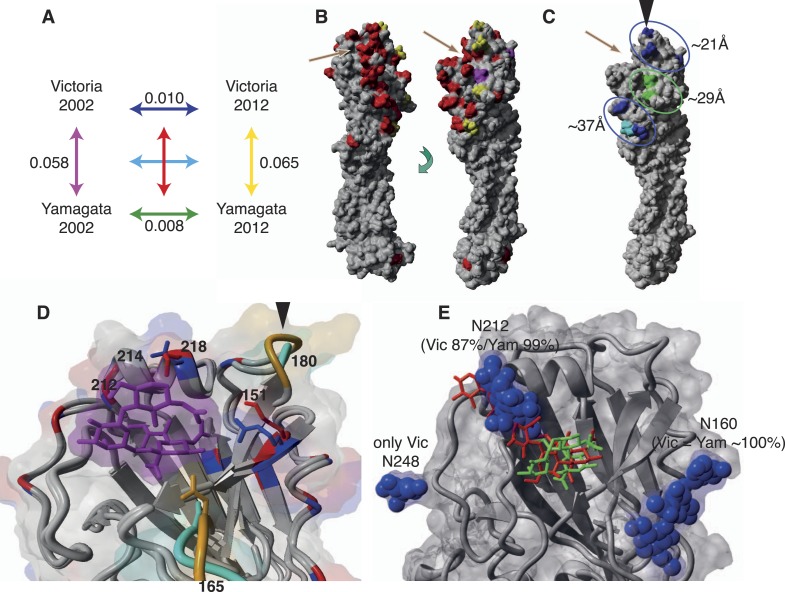
Structural view of the HA showing mutational accumulation and lineage
differences.Amino acid changes observed within and between influenza B virus lineages
(A). Arrow colours in (A) correspond to
inter- (B) or intra- (C) lineage amino acid
changes, based on previously resolved crystal structure (PDB:4FQM). Amino
acids in red represent differences between the two lineages that were
retained over all sampling years; yellow represents differences that are
newly observed in 2012 compared to 2002; and magenta represents changes
lost in 2012 compared to 2002. Amino acids in blue and green represent
changes that occurred in Victoria and Yamagata viruses between 2002 and
2012, respectively; whereas cyan represents difference between 2002 and
2012 shared between both lineages. These amino acid changes occur in
regions that cluster around 21, 29, and 37 Å distant from the RBP
(C). Structural differences in RBP among recent Victoria
(B/Brisbane/60/2008) and Yamagata (B/Florida/4/2006) strains with a
human-like α-2,6 host receptor analogue (magenta)
modeled within the viral RBP (D). D was based
on crystal structures PDB:4FQM and PDB:4FQJ with side-chains minimized
after addition of ligand from PDB:2RFU through superposition. Regions
differing in backbone conformation are shown in orange for Victoria and
cyan for Yamagata, while conserved regions are shown in gray. Residues
with conserved backbone structure but different amino acid side-chains
are shown in red for Victoria and blue for Yamagata. Side-chains are
shown only for residues within 5 Å of the receptor ligand and
differing between the lineages. Structural view of receptor binding
pocket with α-2,6- (green) and
α-2,3-linked (red) host receptor and glycans
(blue) (E). E was based on crystal structure
PDB:4FQM, with the addition of ligands from PDB:2RFU and PDB:2RFT through
superposition and no minimization. The presence of a glycan on site 212
allows binding only to 2,6-linked receptors, while loss of the glycan
allows binding to both α-2,3- and
α-2,6-linked receptors. Brown arrows
(B and C) indicate relative position of
receptor binding pocket (RBP), whereas black arrow heads (C
and D) point to site of known antigenic cluster transition
(Koel et al., 2013).